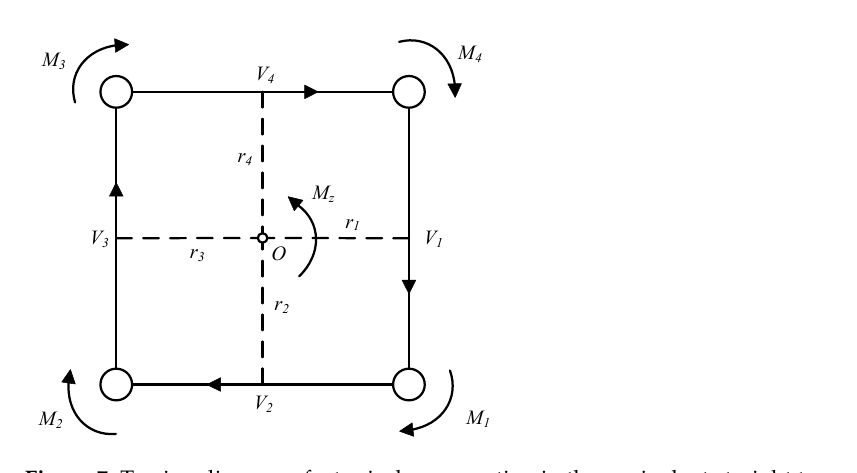
Figure 7. Torsion diagram of a typical cross-section in the equivalent straight truss considering the torsional sti ff ness of chords.